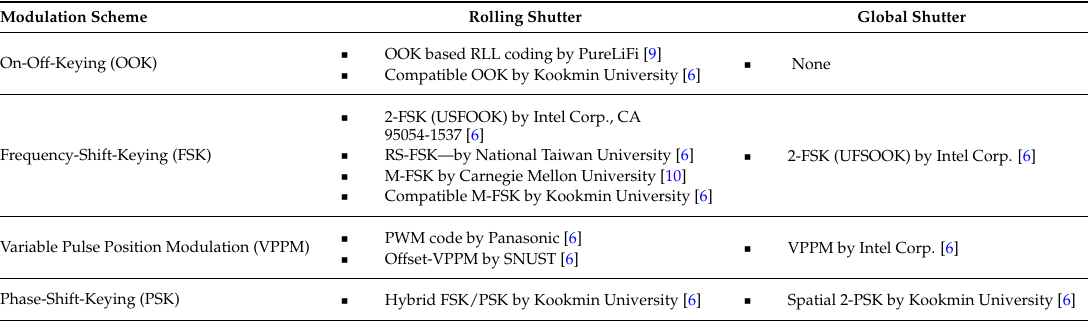
Table 1. A survey of modulation